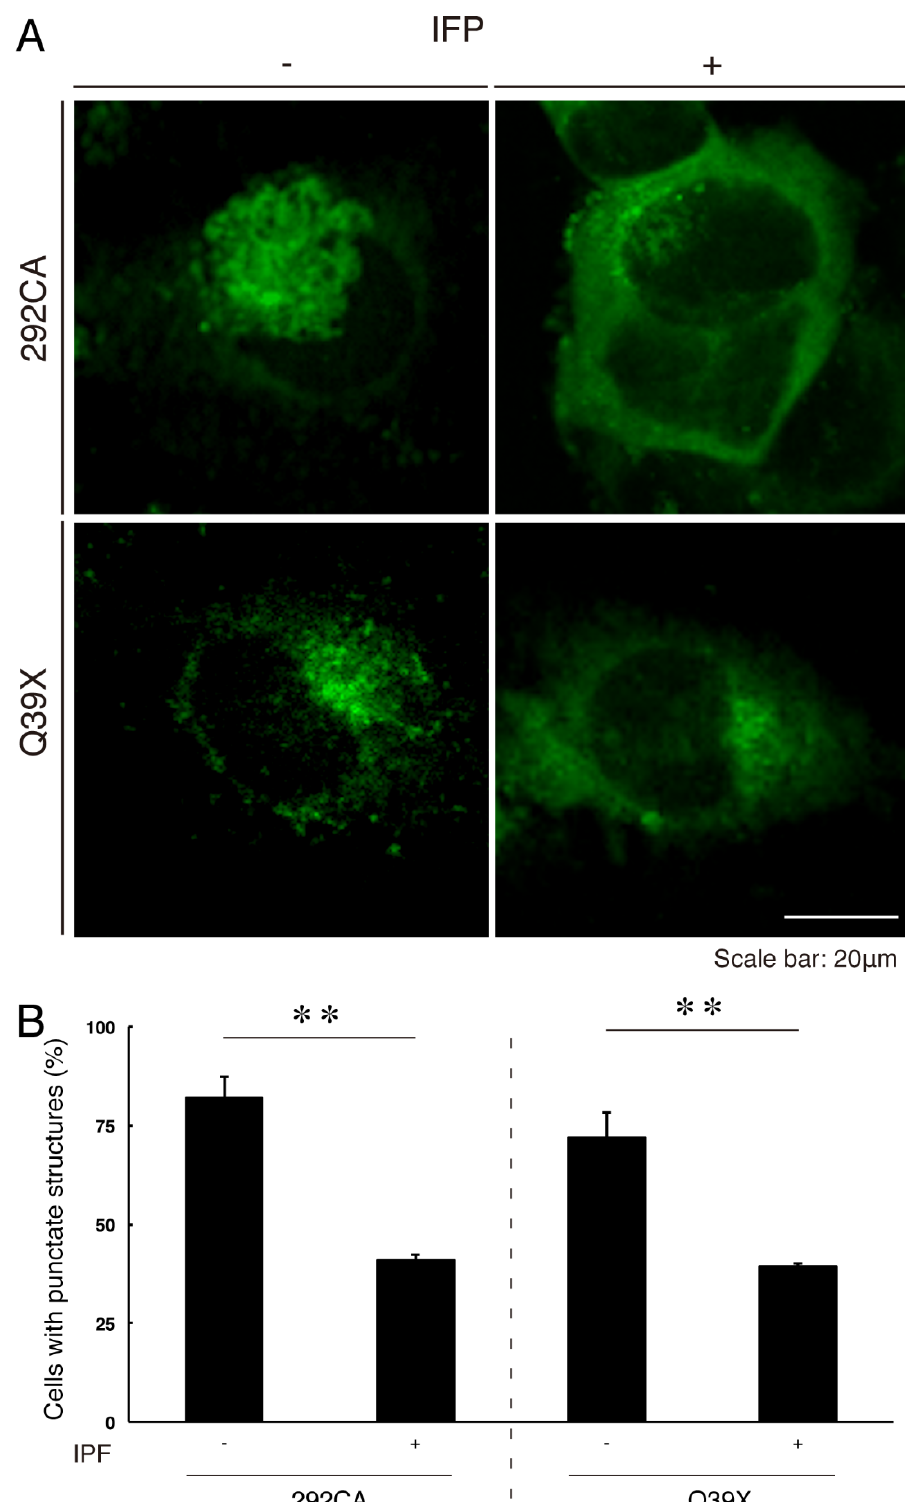
Figure 13. Ibuprofen decreases aggregate-like punctate structures of the AIMP1 ′ s 292CA or Q39X mutant proteins. ( A ) N1E-115 cells were transfected with the plasmid encoding the 292CA or Q39X mutant constructs of AIMP1 with a GFP-tag in the presence or absence (vehicle control) of ibuprofen (IPF). Representative fluorescence images (green) are shown. The scale bar indicates 20 μ m. ( B ) The percentages of cells with punctate structures are shown in a graph (**, p < 0.01; n = 3 fields [total 240 cells]).